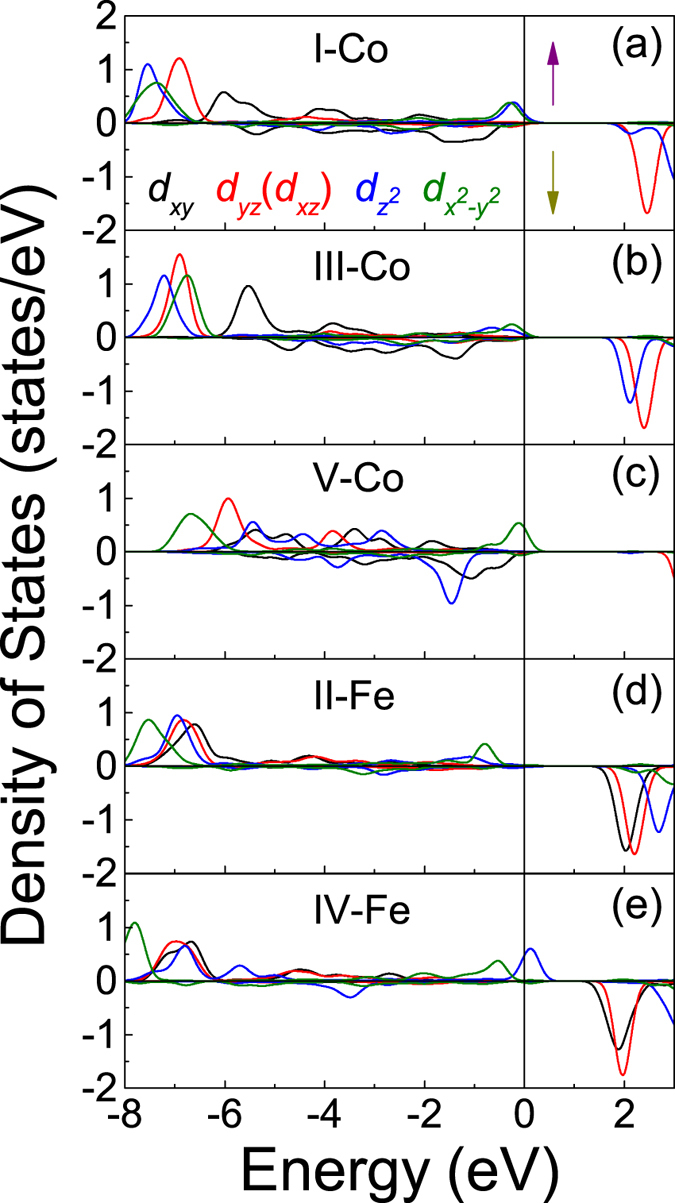
DOS for Co/Fe d electrons in each layer of model CoO2-BiO.EF = 0 eV.